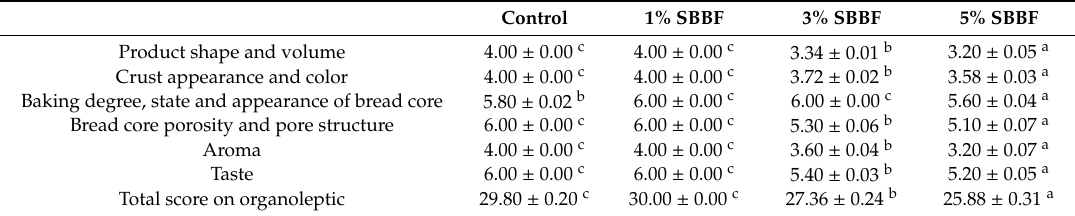
Table 3. Sensory profiles of bread samples prepared with sea buckthorn berry flour (di ff erent letters designate statistically di ff erent